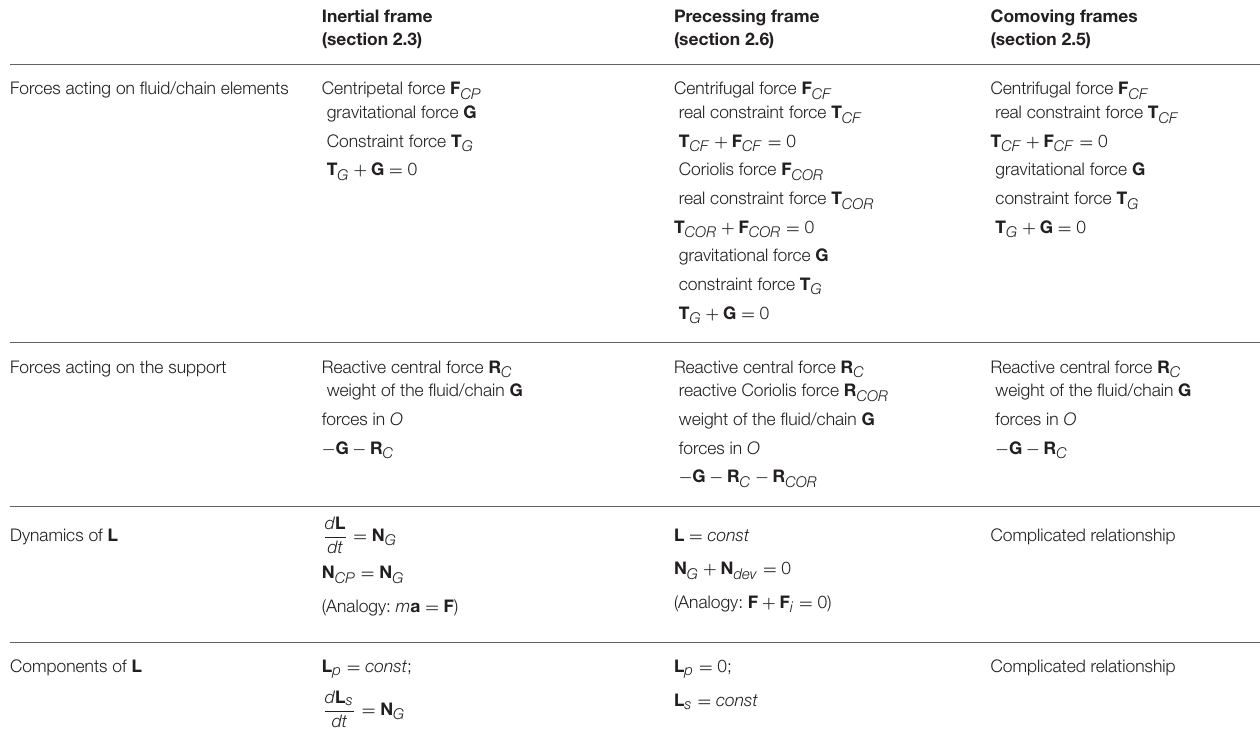
TABLE 1 | Forces and conservation laws in various reference frames.